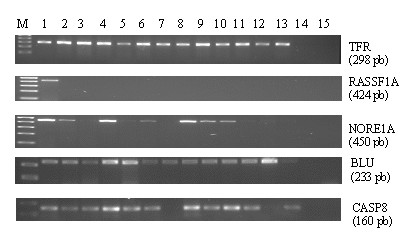
Expression of RASSF1A, NORE1A, BLU and CASP8 in neuroblastoma cell lines determined by RT-PCR and visualized in 2% agarose gels stained with 0.1 μg/ml ethidium bromide. M: 1 Kb Plus DNA Ladder (Invitrogen™ Life and Technologies, Carlsbad, CA, USA); 1: Normal human lung cDNA; 2: Kelly; 3: BE(2)-C; 4: SK-N-MC; 5: SK-N-FI; 6: SK-N-Be(2); 7: IMR-32; 8: MC-IXC; 9: SH-SY5Y; 10: SK-N-SH; 11: MHH-NB-11; 12: SIMA; 13: SK-N-DZ; 14: genomic DNA; 15: water. A fragment of the transferrin receptor gene was amplified as an internal control.